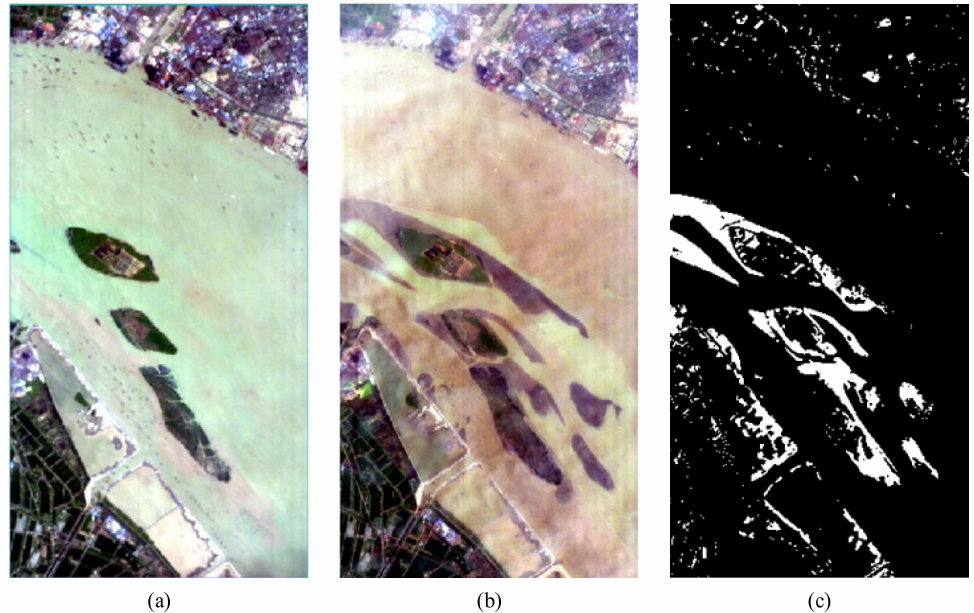
Figure 5. ( a ) Image of May, ( b ) image of December, and ( c ) reference map. Seven measures [39] were employed to conduct the performance evaluation: false positives (FP), the number of the unchanged pixels that are wrongly detected as changed ones; false negatives (FN), the number of the changed pixels that are wrongly detected as unchanged ones; true positives (TP), the number of the correctly detected change